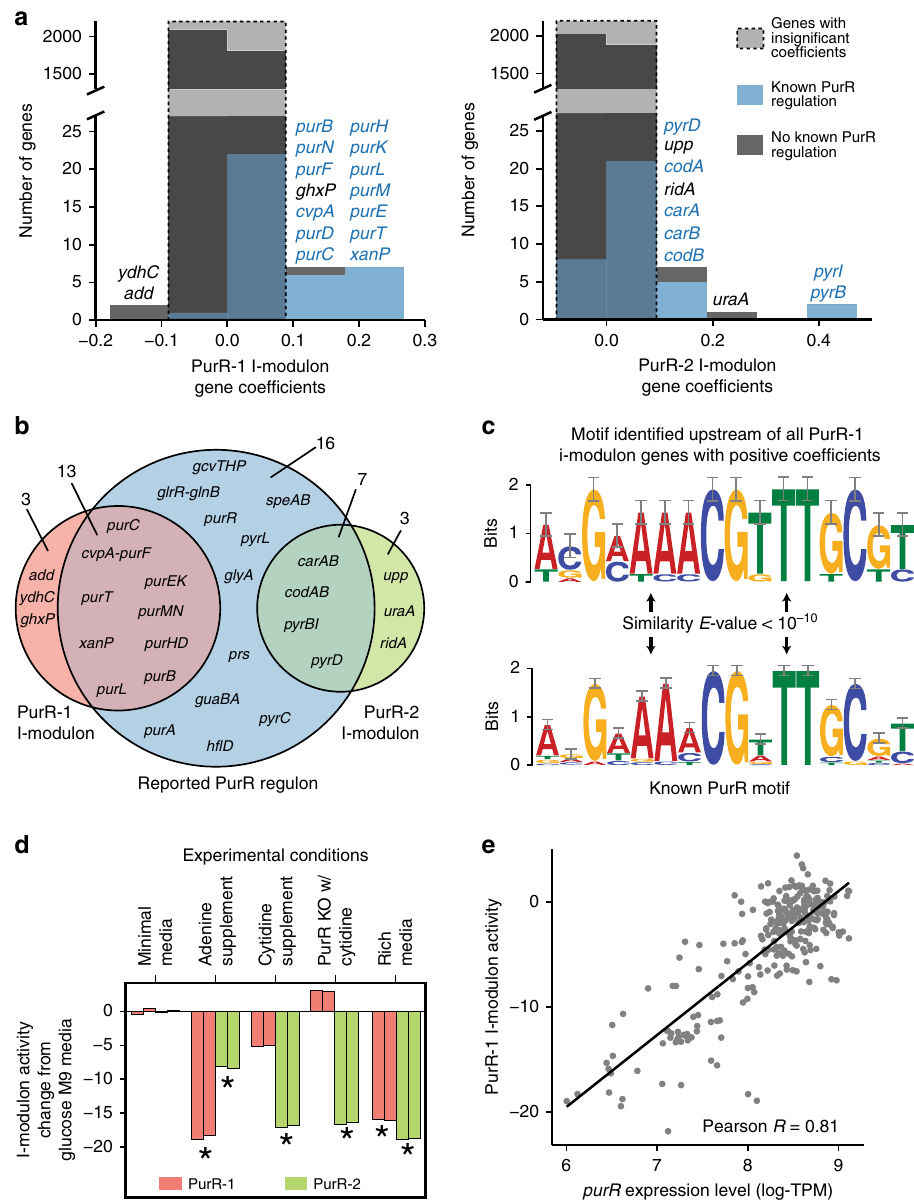
Fig. 3 ICA reveals independent modules within the PurR regulon. a Histograms of gene coef fi cients in the PurR-1 and PurR-2 i-modulons. b Comparison of genes in the reported PurR regulon (blue), PurR-1 i-modulon (red) and PurR-2 i-modulon (green). Gene names for co-transcribed genes were combined (e.g. codAB represents codA and codB ). c Motif identi fi ed upstream of genes in the PurR-1 i-modulon compared to the reported PurR motif from RegulonDB 4 . This motif was identi fi ed upstream of the guanine/hypoxanthine transporter encoding gene ghxP , although regulator binding was not previously reported. d The two PurR-associated i-modulons exhibited distinct responses to environmental perturbations. Asterisks denote signi fi cant i- modulon activities as compared to the reference condition (see the “ Methods ” section). Each bar represents a single biological replicate. e The PurR-1 i- modulon activity level is highly correlated with purR expression level across all conditions (excluding the PurR knock-out), whereas the PurR-2 i-modulon activity exhibits poor correlation (see Supplementary Fig. 4d). Similar information on all 92 i-modulons is available in Supplementary Data 2. Abbreviations: log-TPM log-transformed transcripts per